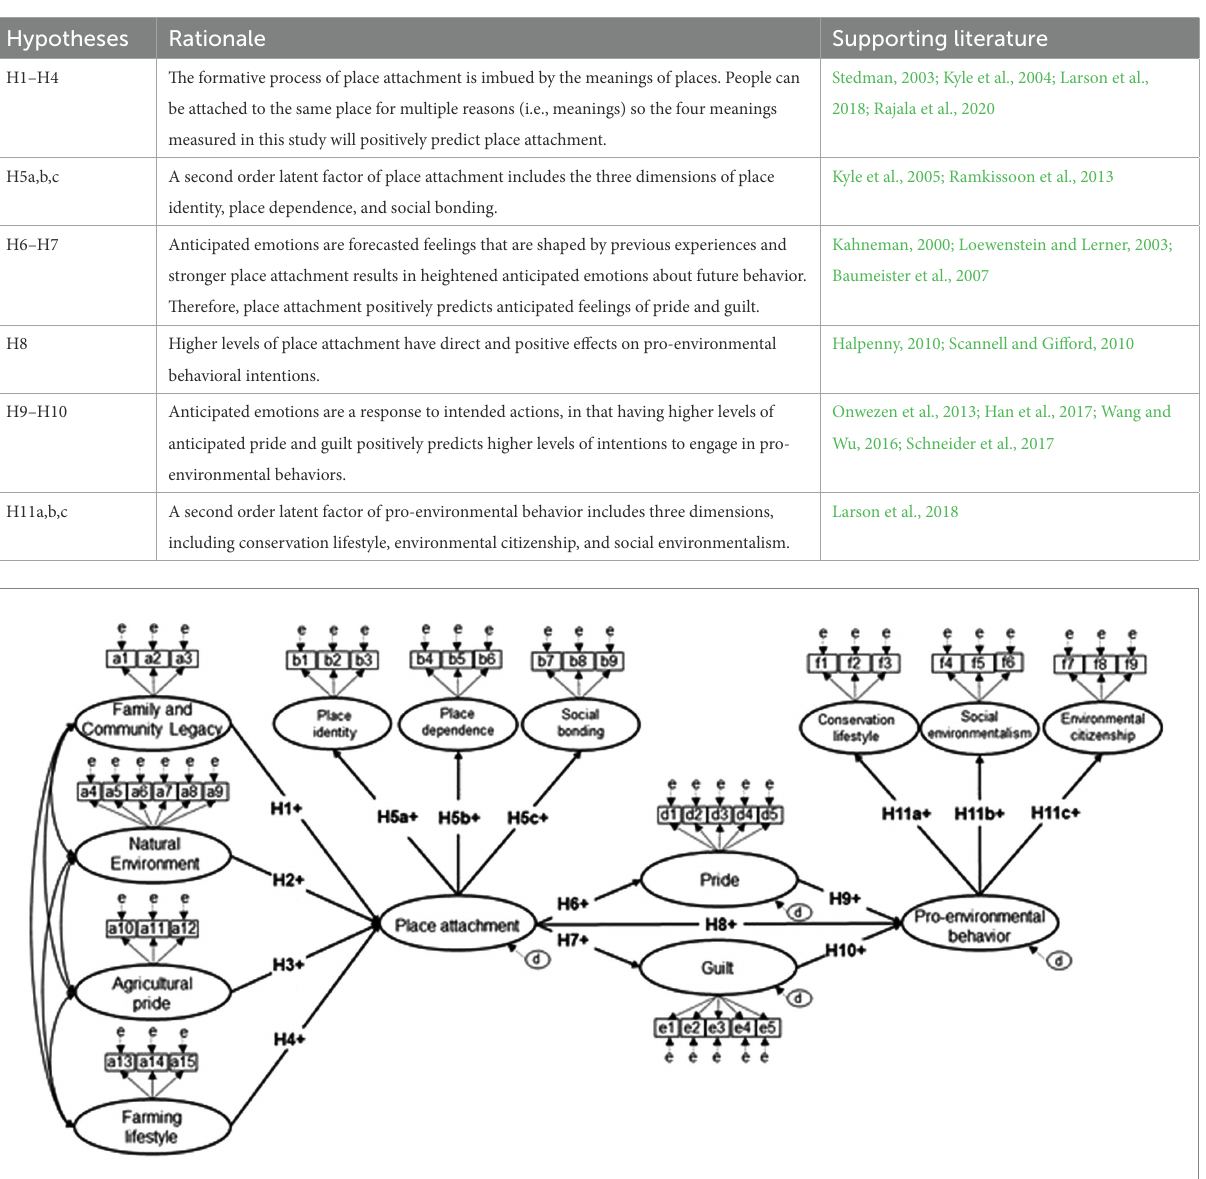
FIGURE 1 Hypothesized relationships among place meanings, place attachment, anticipated emotions, and pro-environmental behavior.